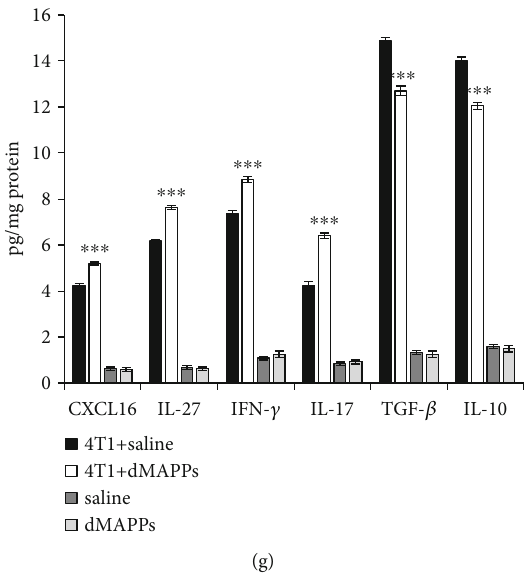
Figure 2: d-MAPPS enhanced concentration of antitumorigenic and reduced concentration of immunosuppressive cytokines in serum and tissue samples of tumor-bearing mice. Concentration of antitumorigenic (CXCL16, IL-27, IFN- γ , and IL-17) and immunosuppressive cytokines (TGF- β and IL-10) in (a – f) serum and (g) tumor tissue samples of BALB/c mice from experimental groups (4T1+saline- treated (black bars) and 4T1+d-MAPPS-treated animals (white bars)) and control groups (saline-treated (dark grey bars) and d-MAPPS-treated animals (light grey bars)). Data are presented as mean + / − SEM ( n = 16 mice/experimental group and n = 8 /control group; ∗∗∗ p < 0 : 001